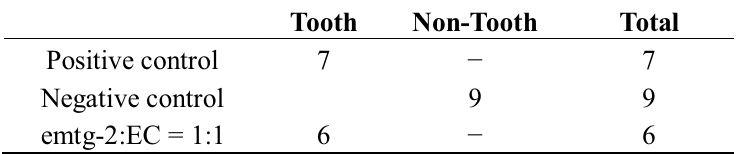
Table 1. Tissues grown from implanted tooth germs (emtg-2: dental epithelial cells [EC] = 1:1). Tooth